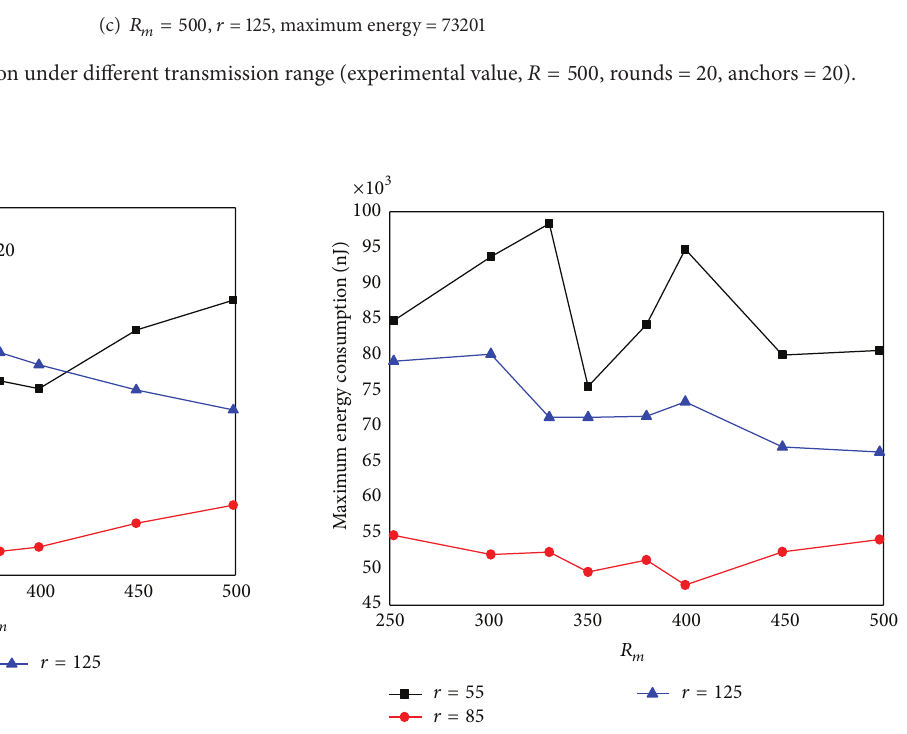
Figure 30: Maximum energy consumption under different trans- mission range and 𝑅 𝑚 (theoretical value).